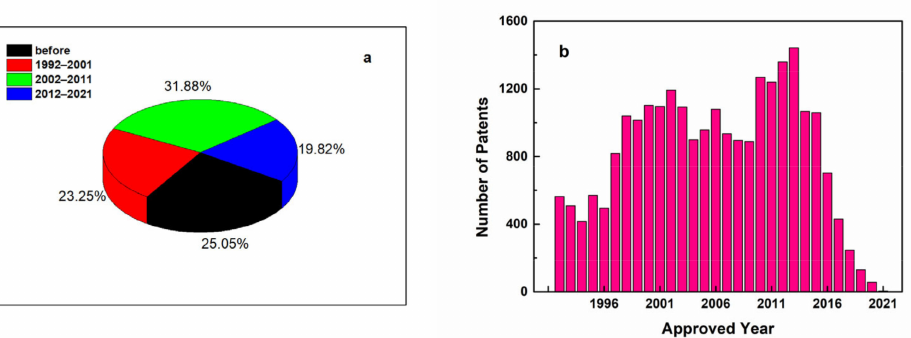
Figure 3. The proportion of patents related to ascorbic acid search terms before 2021 ( a ) and the number of ascorbic acid patents in each of the past 30 years ( b